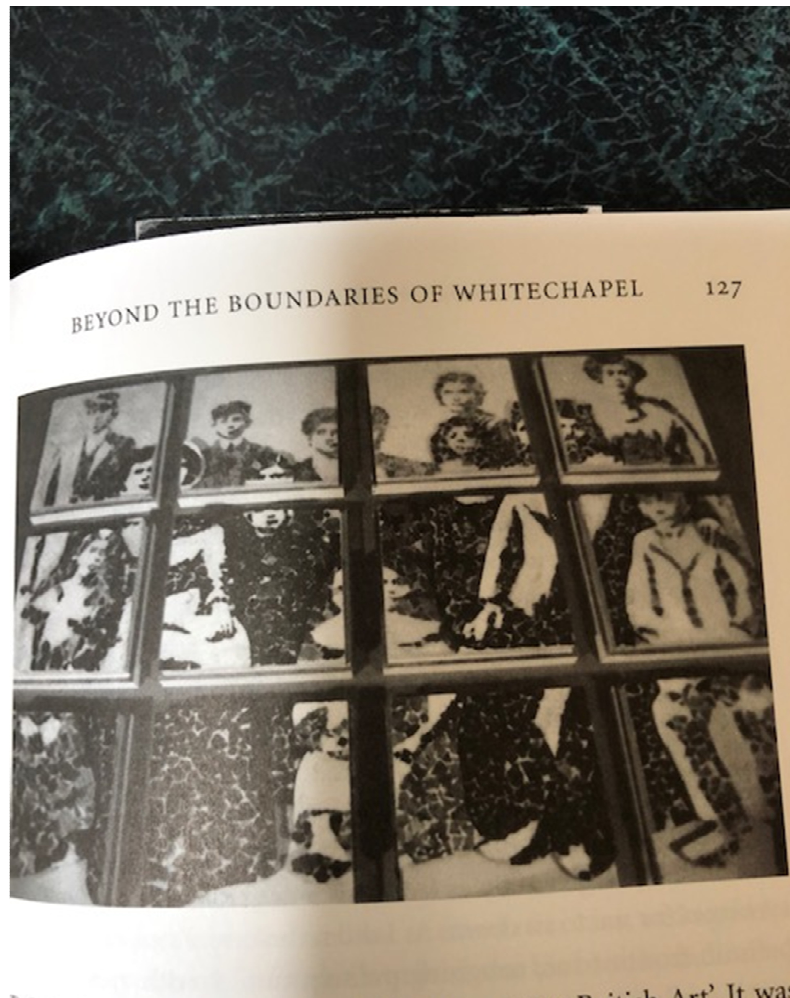
Figure 4. Kirsch Family Mosaic.